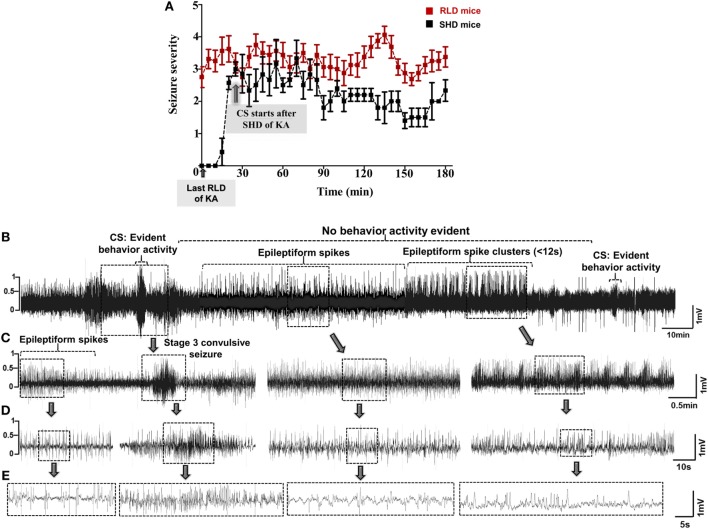
(A) Seizure severity comparison between single high dose (SHD) and repeated low dose (RLD) of KA in mice during SE. Animals in RLD group showed more severe seizures and spent more time in ≥3 stage when compared to the SHD group during the 3 h of SE. Animals in both groups were given 20–30 mg/kg kainate (i.p.) (***p < 0.0001, two-way ANOVA between 1 and 719 degrees of freedom, F = 148.60, n = 30 for each group). Adopted and modified from Tse et al. (2). (B–E) An example of a 30-min EEG trace, during SE, showing inter-ictal activity that comprises of continuous epileptiform spikes and seizure cluster <12 s without any behavioral phenotype. Convulsive seizures (CS) and non-convulsive seizures (NCS) were observed throughout SE, but behavior activity was evident only during CS, i.e., stage ≥3. Expanded electroencephalography (EEG) traces of (B) are shown in panels (C–E).